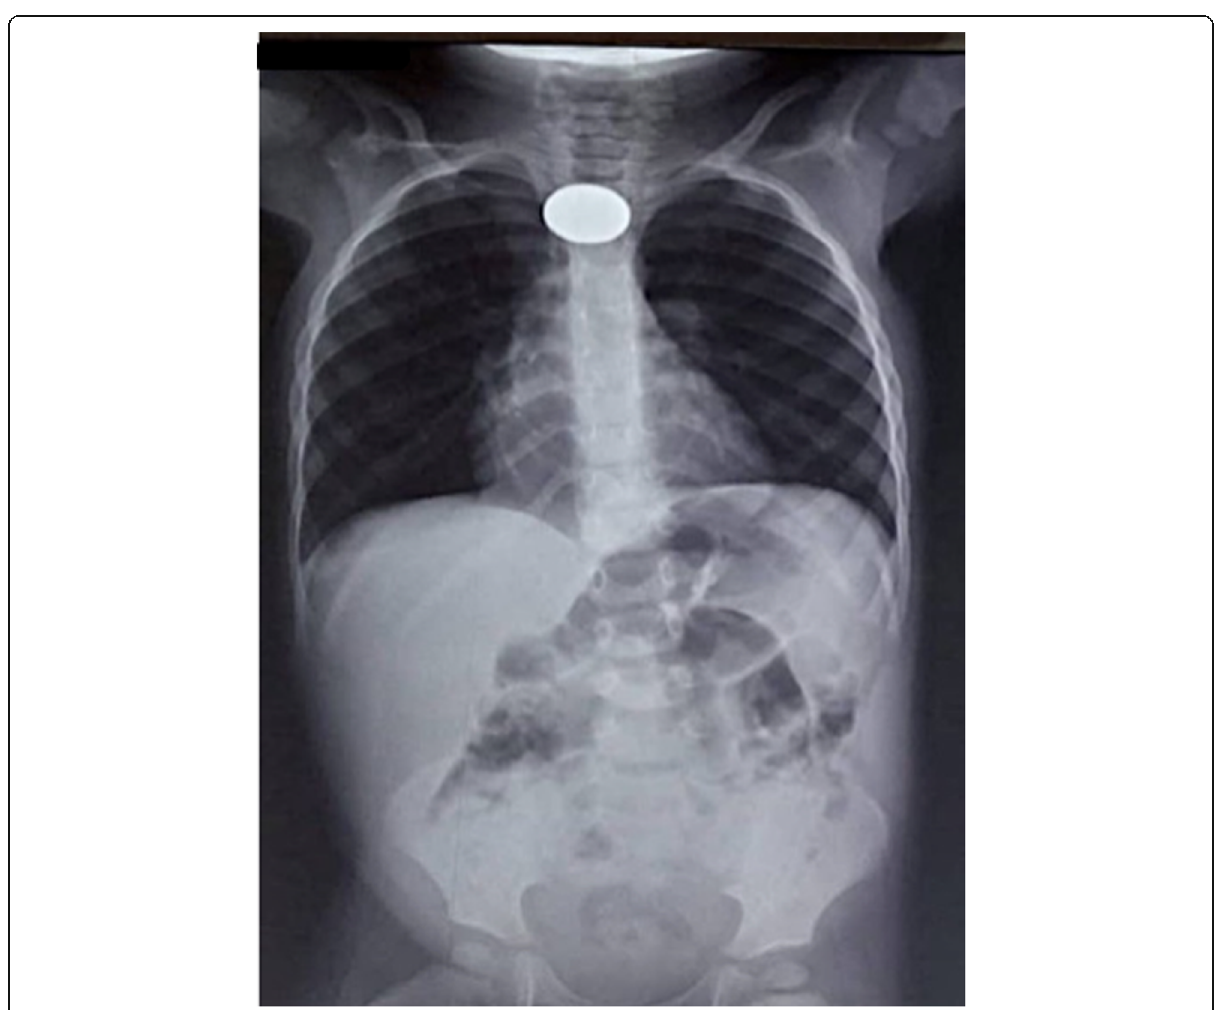
Fig. 1 Chest X-ray before attempted instrumental extraction revealing the coin located at the upper third of thoracic